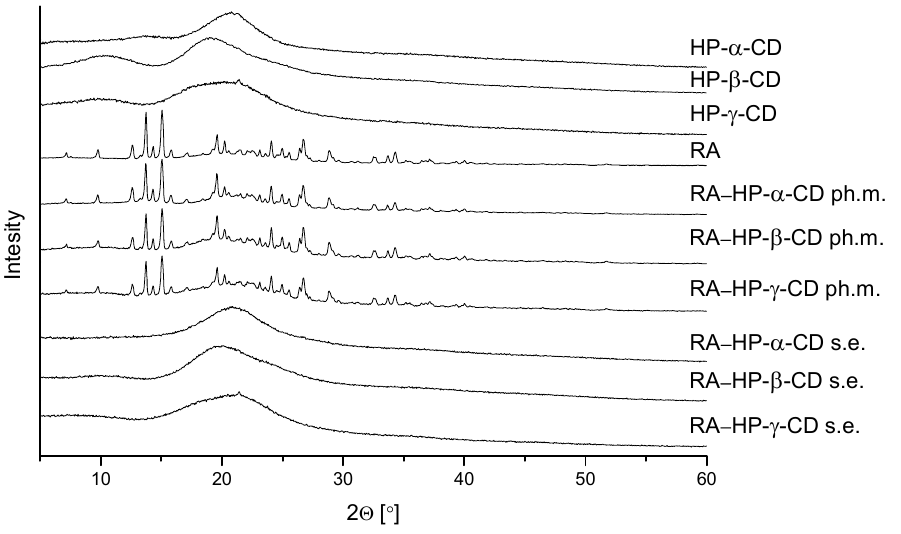
Figure 2. The XRPD diffraction patterns of HP-α-CD, HP-β-CD, HP-γ-CD, RA, physical mixtures: